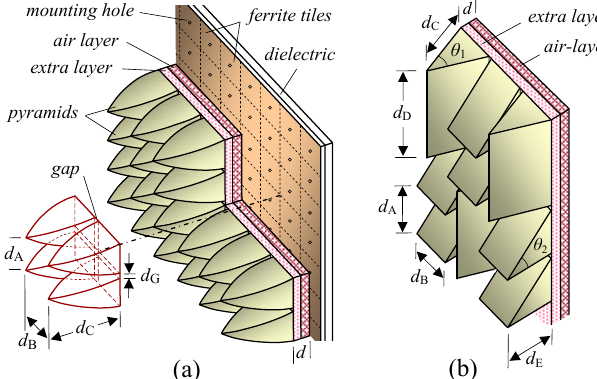
Figure 18: General structure of two enhanced absorber setups. (a) A curvilinear pyramidal multilayer lining and (b) a set of adjustable alternating